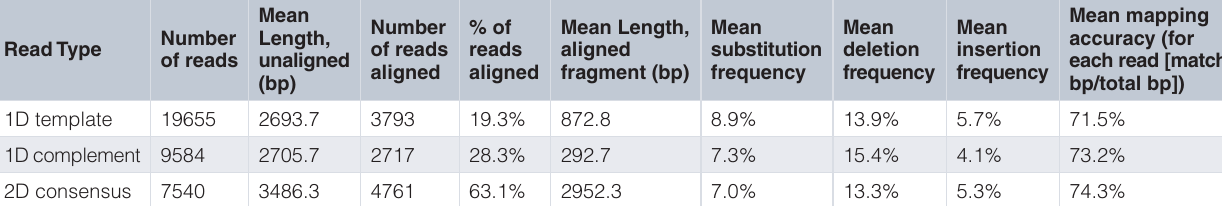
Table 1. Basecall and read mapping